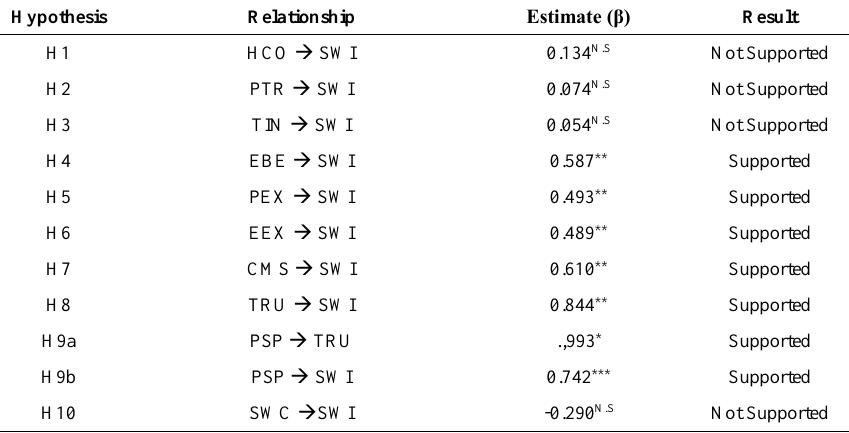
Table 4. Hypothesis testing